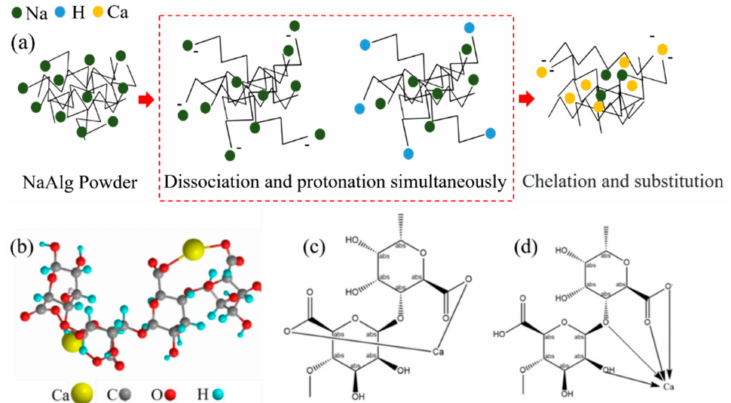
Figure 1. The preparation schematic diagram of PCA and the molecular structure of ca-alginate: ( a ) preparation schematic diagram of PCA, ( b ) the molecular chain of ca-alginate, ( c ) ionic bond, and ( d )